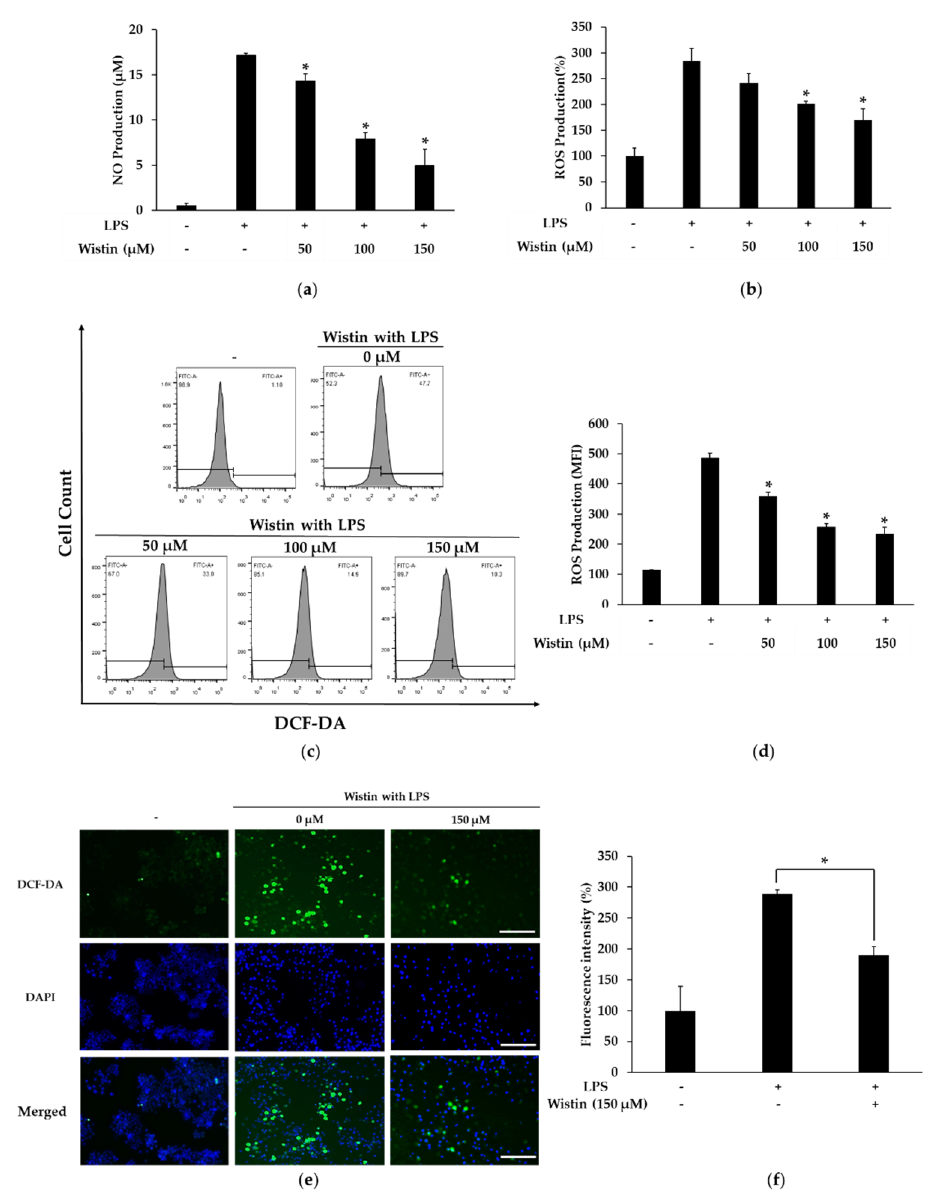
Figure 2. The effect of wistin on NO and ROS production in LPS-stimulated RAW264.7. The cells were treated with the indicated concentrations of wistin for 30 min prior to treatment with LPS (0.1 µ g/mL) for 24 h. ( a ) The NO production was measured in treated wistin in the culture supernatant. ROS production was measured on a microplate reader ( b ), FACS ( c , d ), and fluorescence microscope ( e ). ( f ) Quantitative analysis of ROS production using ImageJ software. The scale bar represents 100 µ m. * p < 0.05 compared with the LPS-treated group. MFI: mean fluorescence intensity. The data are presented as the means ± SD; n = 3.